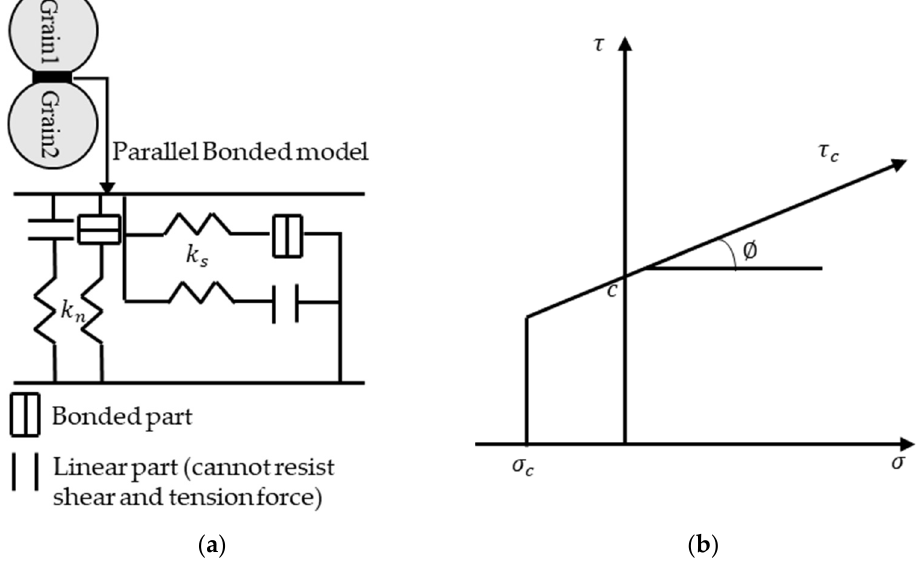
Figure 4. Parallel Bonded model. ( a ) Structure components of the Parallel Bonded model; ( b ) the strength envelope of the Parallel Bonded model.